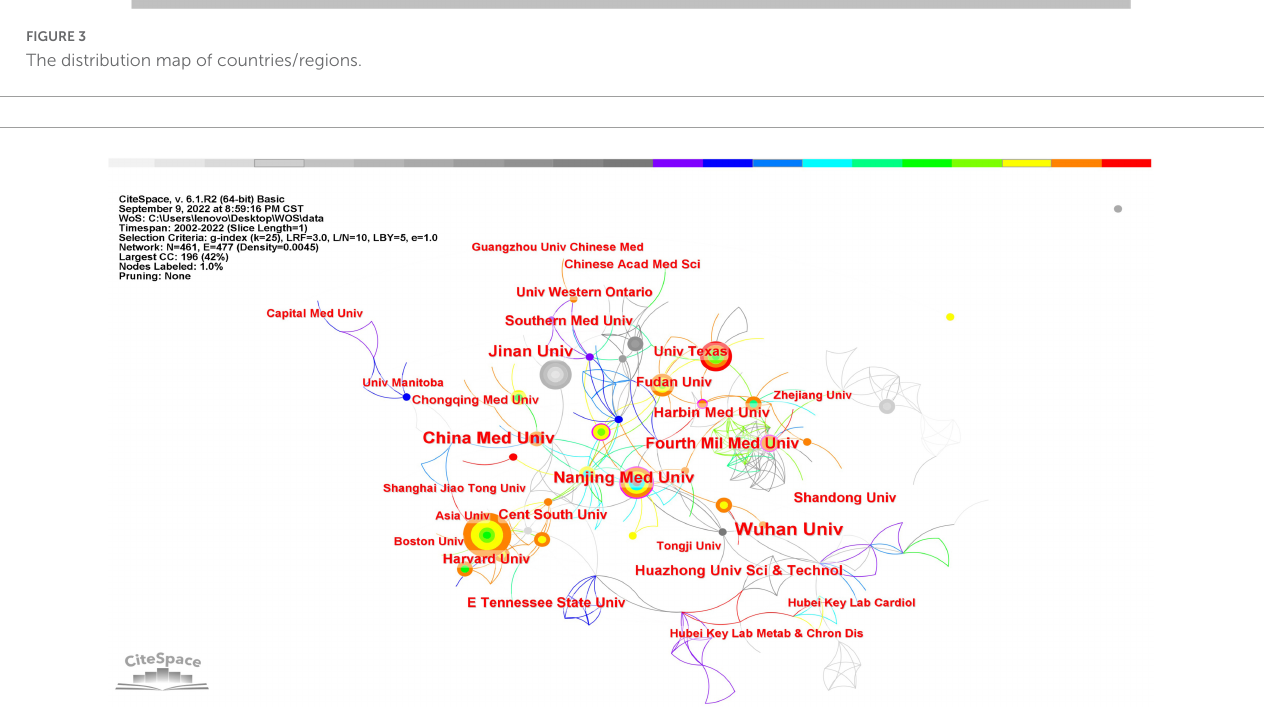
FIGURE4 CiteSpace visualization map of institutions related to